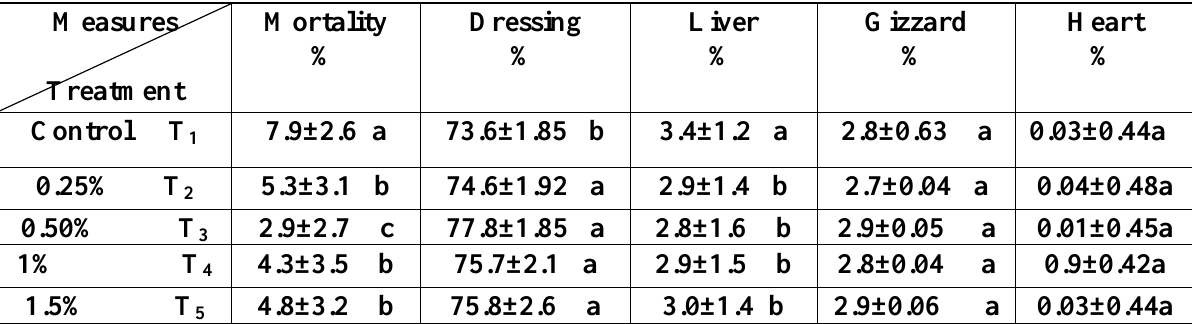
Table (4) Effect of turmeric (Curcuma longa) on blood characteristics of broiler ±SE.